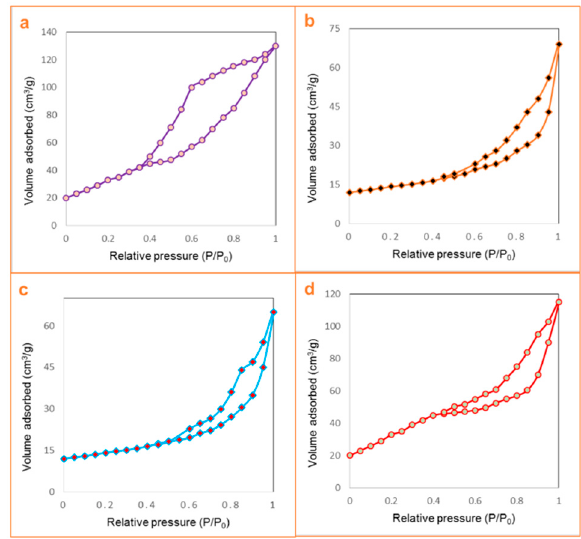
Figure 2. Nitrogen adsorption-desorption curves of ( a ) MNs, ( b ) Fe 3 O 4 NPs, ( c ) bare nZVI, and ( d ) MFNNs.